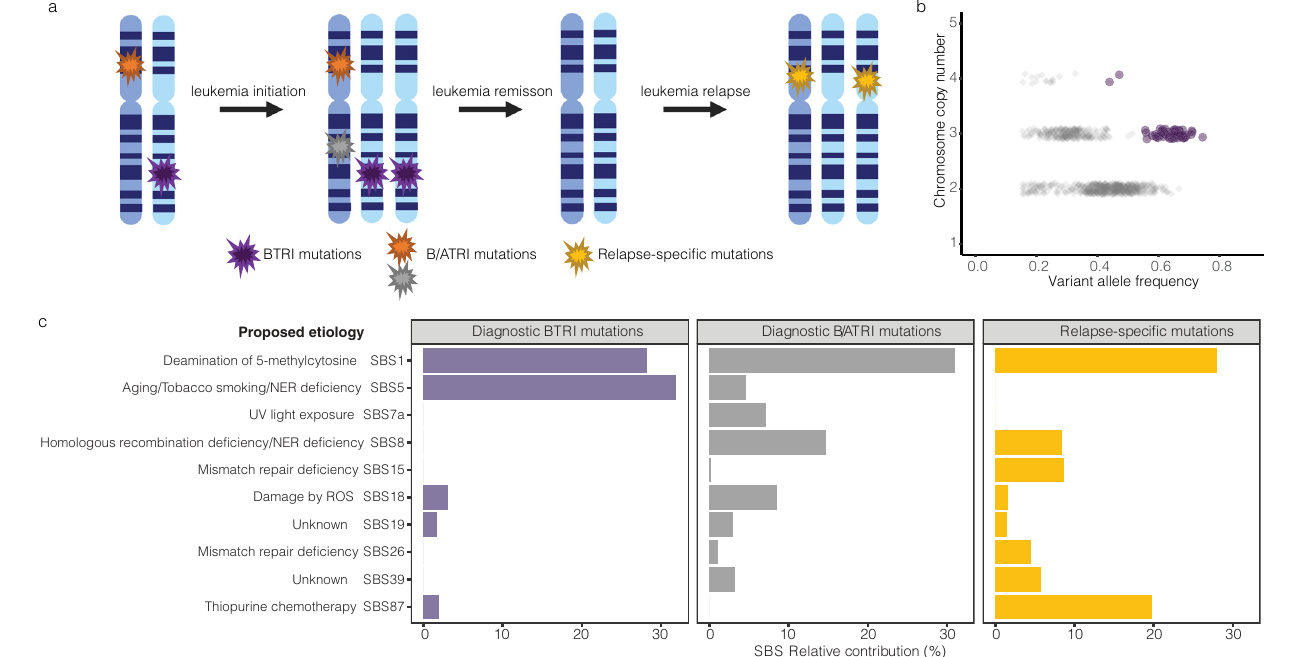
Fig.5|Patternsofsomaticmutationsinhighhyperdiploidacutelymphoblastic leukaemia. a Timeline of mutations arising either before the trisomies (BTRI mutations),before/afterthetrisomies(B/ATRImutations),andatrelapse. b Variant allelefrequencies(VAFs) in bulk sequencing data of scWGS case 1 for allmutations in relation to copy number based on the number of reads for that particular chromosome segment. BTRI mutations, which are present in 2/3 chromosomal homologues and have VAFs of ~0.67, are shown in purple and B/ATRI mutations,